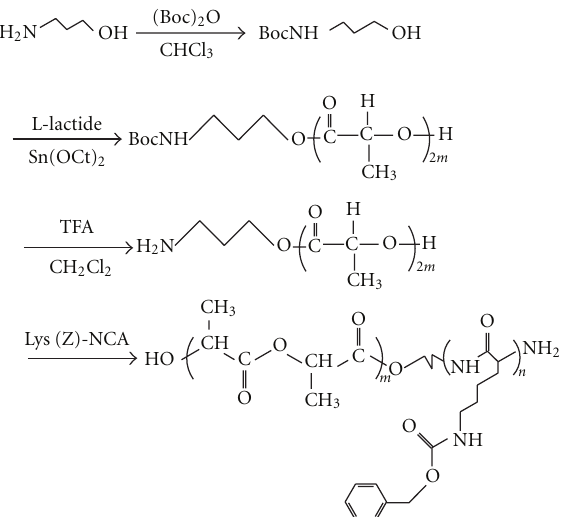
Figure 1: Synthesis of NH 2 -PLLA and PLLA- b -PZLys block copol-